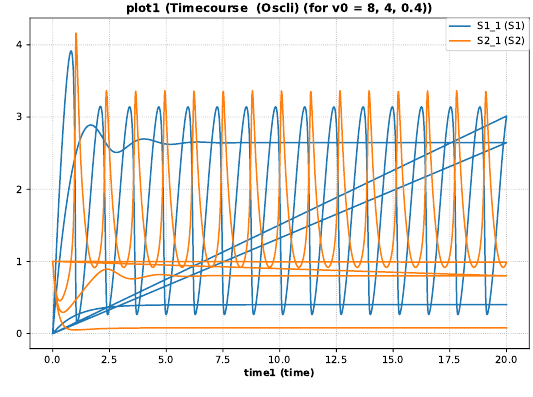
Figure A.3: The simulation result gained from the simulation description given in Listing A.3. Simulation with SED-ML web tools [2].